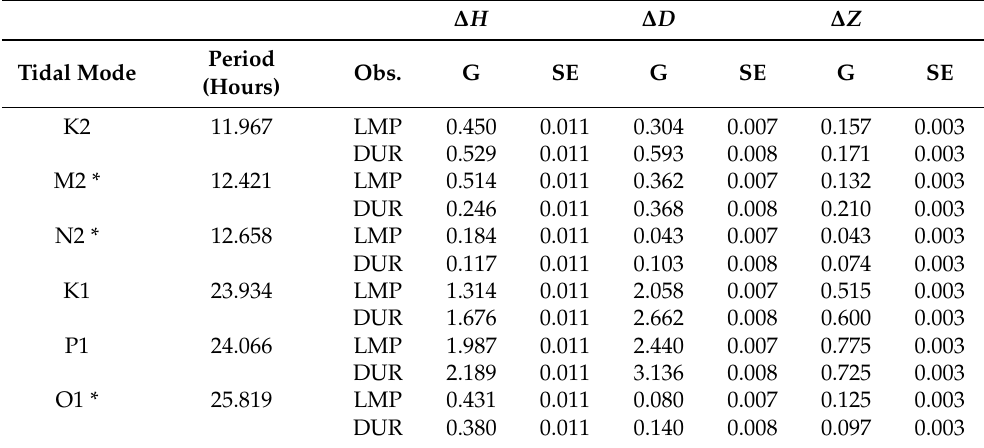
Table 1. Estimated amplitude G and standard errors SE (both expressed in nT) of geomagnetic field variations at tidal mode frequencies obtained through robust fit procedure during nighttime dataset for the years 2017–2020 and for both observatories (Obs.). The lunar tidal modes of interest are marked with the (*) symbol.